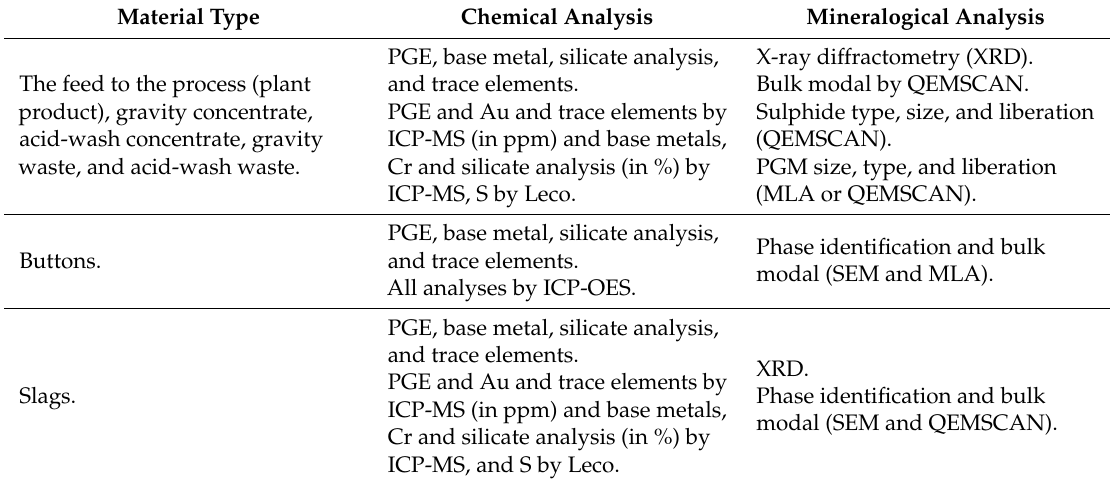
Table 1. Type of analysis requested for the different samples collected during the